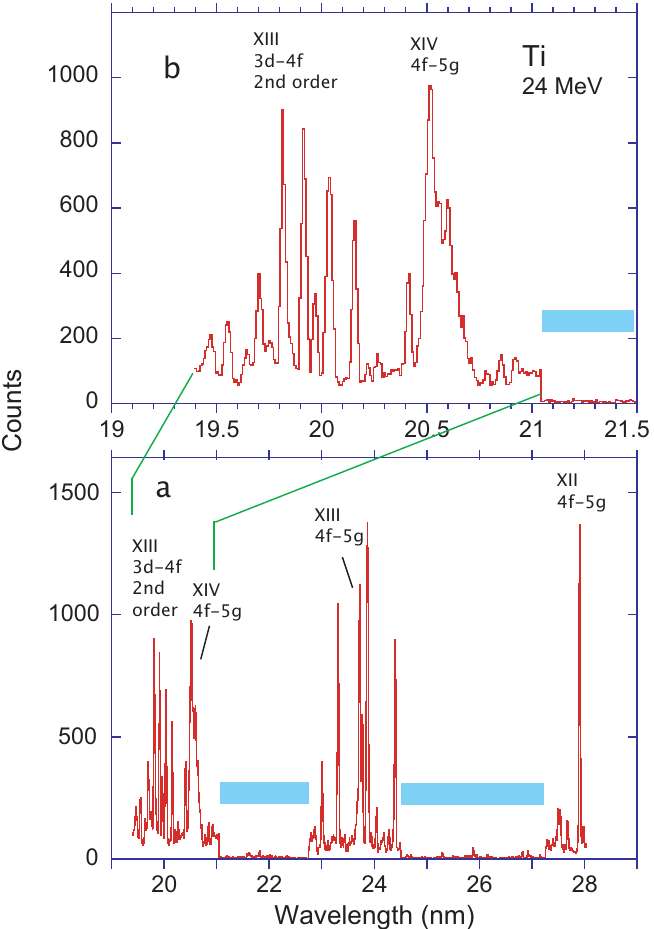
Figure 10. Beam–foil spectra of Ti at an ion beam energy of 24 MeV. Grating 600 L/mm, line width (FWHM) 0.030 nm. The charge state distribution is centered on q = 11 + and q = 12 + , and ion charge states q = 9 + to q = 15 + are expected to contribute. ( a ) Survey spectrum covering the 4f–5g transition arrays in Ti XII, XIII, and XIV. Near a wavelength of 20 nm, the Ti XIII 3d–4f transition array shows in the second diffraction order. ( b ) This detail has been expanded for the benefit of a comparison with Figure